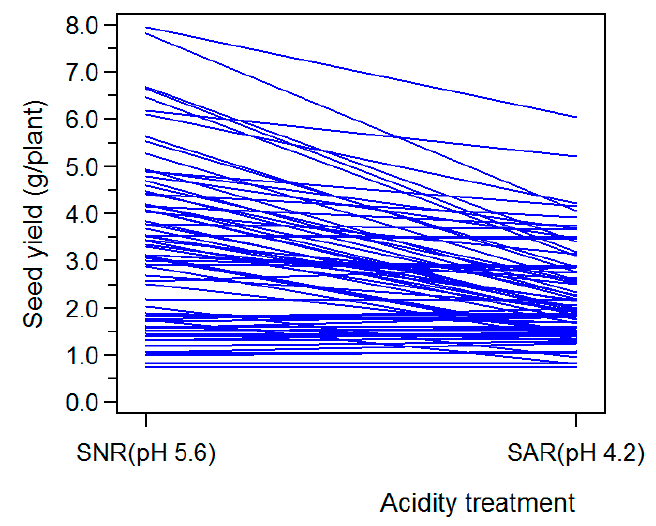
Figure 1. Differential response (reaction norms) of soybean genotypes to SAR stress for seed yield. Each line represents a genotype. To avoid unclear presentation, only a subset of the whole surveyed genotypes was given.